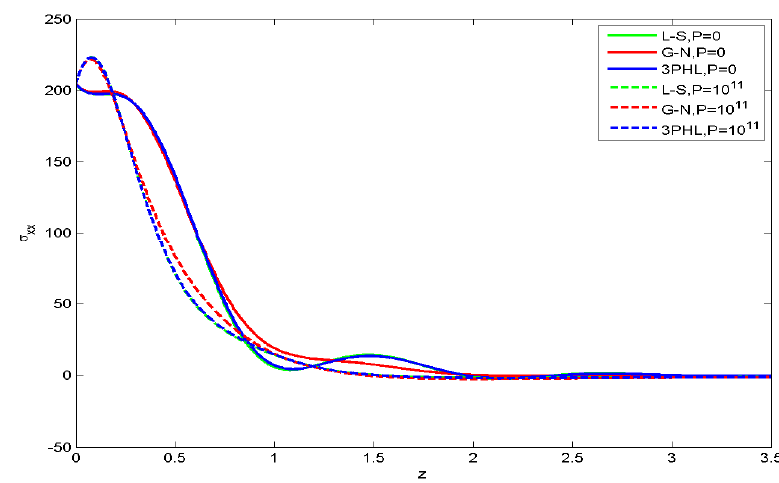
Figure 3. Displacement w concerning z under thermoelastic theories.